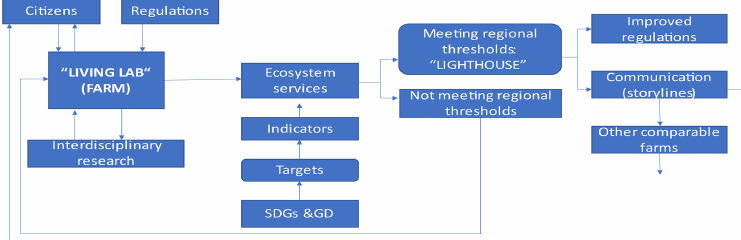
Figure 2. A schematic representation of processes and interactions involved when transforming living labs into lighthouses (see text). Table 1. Ecosystem services determined for a living lab, an arable farm on calcareous light clay soils in Flevoland, the Netherlands (from Bouma et al., 2022). Conclusion: this living lab does not yet qualify as a Lighthouse. Ecosystem service Indicator Threshold Result SDG2: biomass production Local yields and Yw 80%Yw Positive SDG3: pollution EU & local reg. EU & local reg. Positive SDG6: water quality EU & local reg. EU & local reg. Negative SDG13: greenhouse gas em. Not defined Not defined Negative SDG15: biodiversity pres. Not defined Not defined Negative SDG15: land degradation Soil health Of 5 indicators